Question: Draft a figure caption describing what is shown.
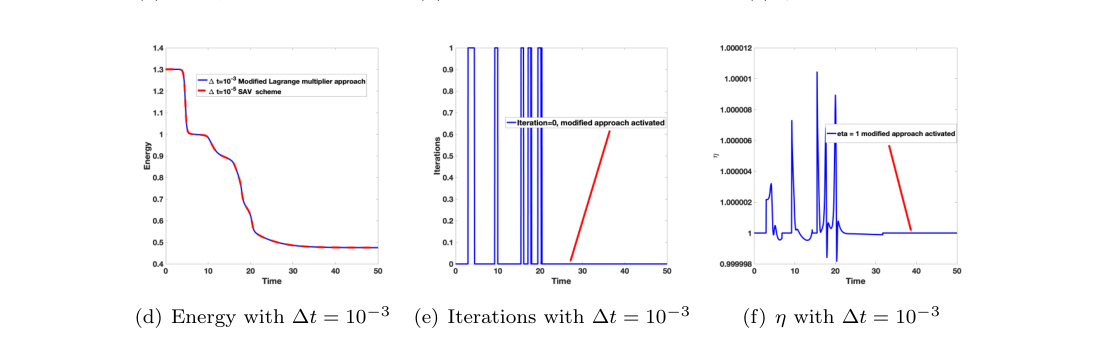
Answer: (a-c): The evolution of energy, iterations and η using the original Lagrange multiplier approach with ∆t = 10−7. (d-f): The evolution of energy, iterations and η using modified Lagrange multiplier approach with ∆t = 10−3.